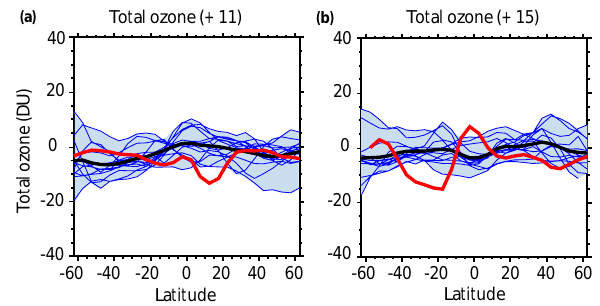
Figure 5. (a) Deseasonalized SBUV total ozone (in Dobson units) as a function of latitude 11 months after wind shear reversal from easterly to westerly from 14 QBO cycles prior to 2015–2016 (blue lines), the composite (black line) based on 14 QBO cycles, and 2015–2016 (April 2016; red line). (b) The same as (a) only for to- tal ozone at + 15 months, corresponding to August 2016. The blue shading shows the observed O 3 range at + 11 and + 15 months, re- spectively, for all 14 QBO cycles (excluding the 2015–2016